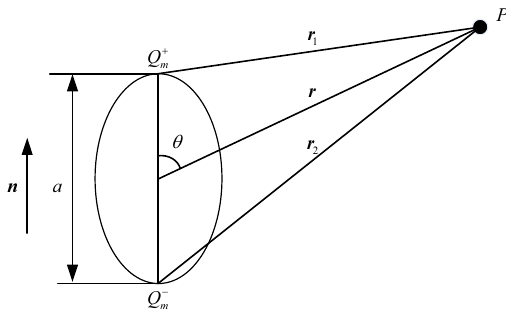
Figure 2: Schematic illustration for the intensity of the magnetic fi eld induced by a magnetic dipole P.